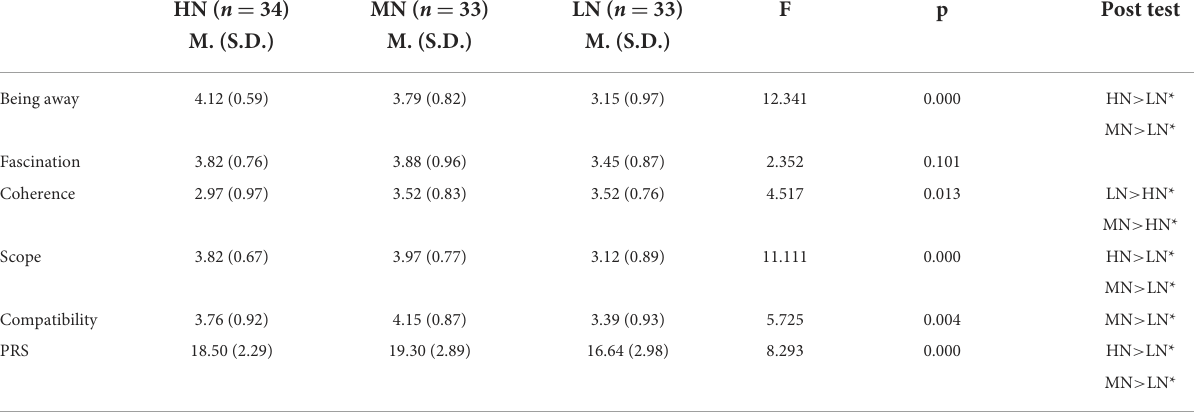
TABLE 2 One-way ANOVA analysis of PRS for environments with different degrees of perceived naturalness in urban